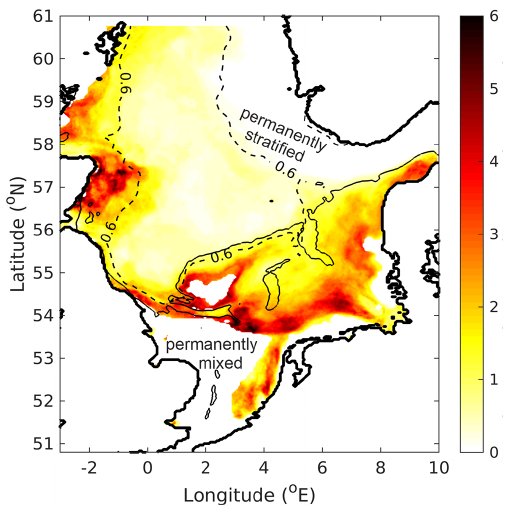
Figure 9. Ratio of the number of water stratification days to the number of MHW days. The dashed contour line corresponds to the correlation coefficient R = 0 . 6 between the air temperature and the potential energy anomaly for the multiyear mean of the summer time. The thin solid line indicates the 50m isobath.